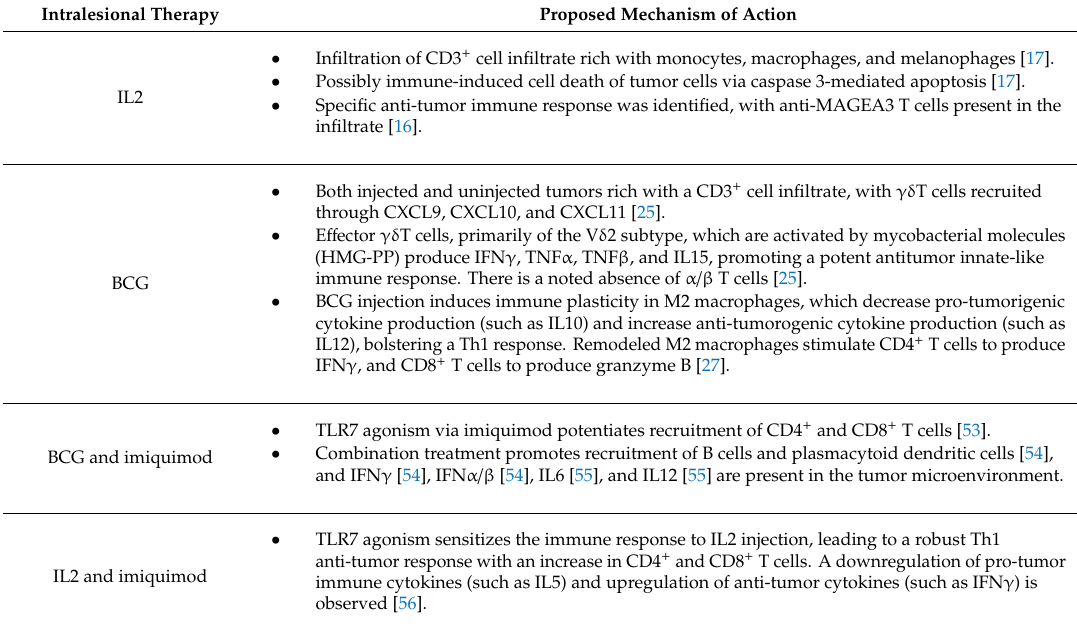
Table 2. A summary of the proposed immunomodulatory mechanism of action of the di ff erent intralesional therapies